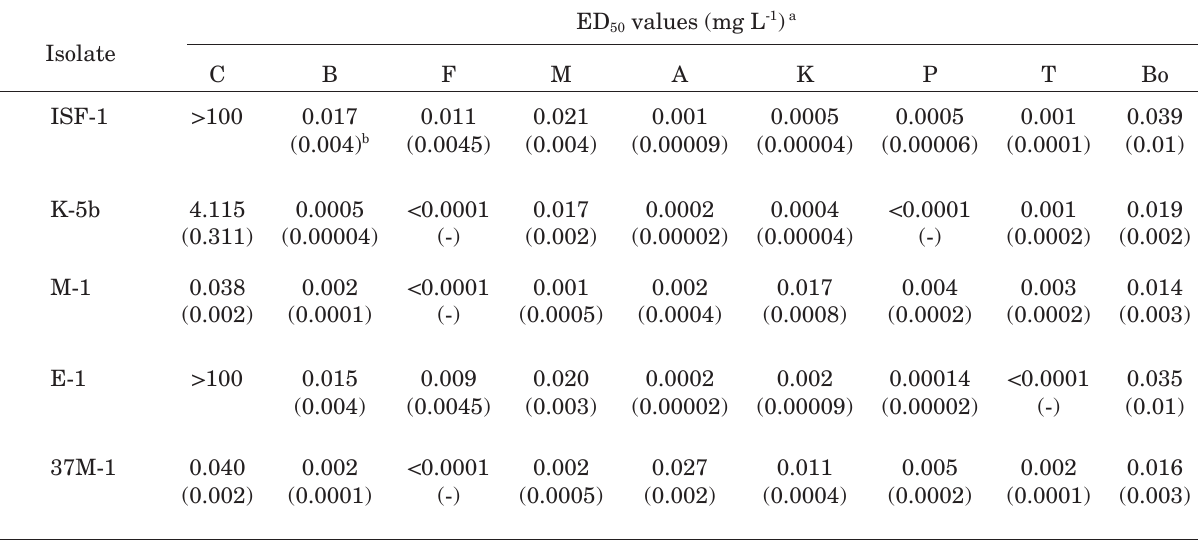
values a of representative isolates of Septoria pyricola to carbendazim (C), bitertanol (B), flusilazole (F), 50